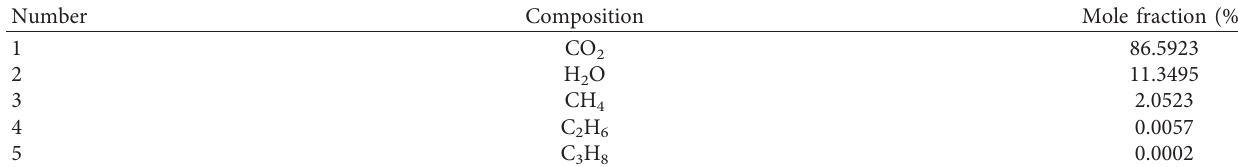
Figure 2: Flow diagram of direct DME synthesis. Table 1: Feed gas composition of the acid gas.